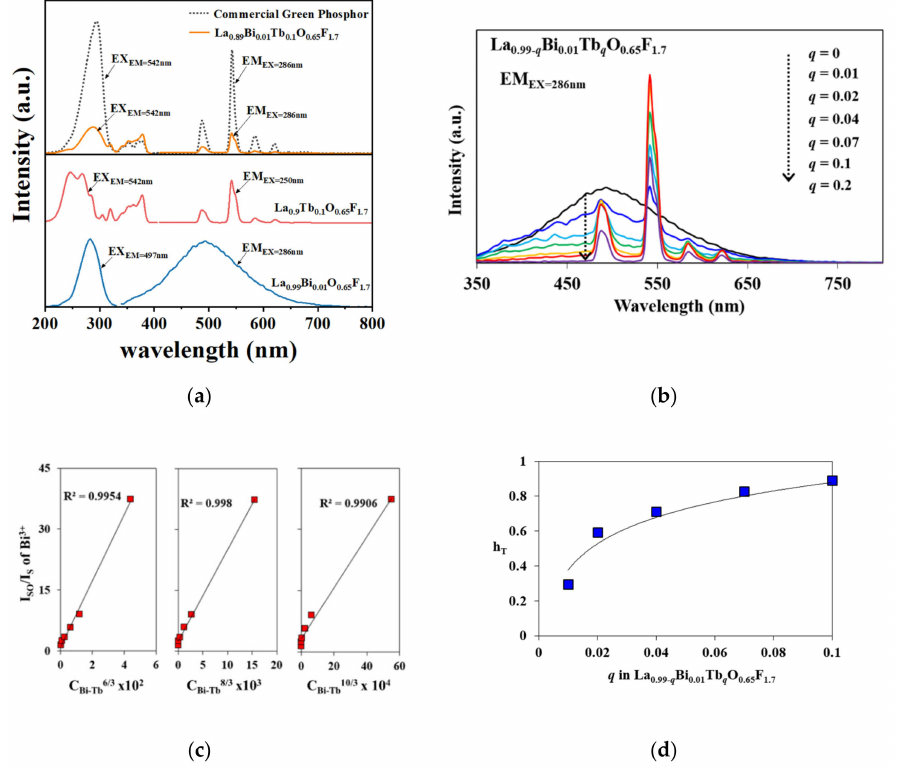
Figure 4. ( a ) PL excitation and emission spectra of La 0.99 Bi 0.01 O 0.65 F 1.7 , La 0.9 Tb 0.1 O 0.65 F 1.7 , La 0.89 Bi 0.01 Tb 0.1 O 0.65 F 1.7 , and commercial green LaPO 4 :Ce 3+ /Tb 3+ phosphors; ( b ) the emission spec- tra of La 0.99 − q Bi 0.01 Eu q O 0.65 F 1.7 ( q = 0–0.2) phosphors under 286 nm excitation; ( c ) the plot of I SO /I S versus C Bi-Tb α /3 ( α = 6, 8, and 10); ( d ) energy-transfer efficiency from Bi 3+ to Tb 3+ in the phosphors. As shown in Figure 5, the chromaticity coordinates, x and y , were in accordance with the desired CIE values from the blue to green wavelength regions for La 0.99 − q Bi 0.01 Tb q O 0.65 F 1.7 ( q = 0–0.2) phosphors (EX = 286 nm). When the concentration of Tb 3+ ions in the La 0.99 − q Bi 0.01 Tb q O 0.65 F 1.7 ( q = 0–0.2) phosphors increased from q = 0 to 0.02 and 0.1, the emission colors exhibited a gradual shift from blue to green emission regions. The CIE values are summarized in the inset of Figure 5, along with the values obtained for the phosphors. The CIE coordinates of the blue and green regions of the phosphor CIE diagram were observed to be x = 0.240 and y = 0.334, x = 0.239 and y = 0.340, x = 0.254 and y = 0.436, and x = 0.267 and y = 0.535 for values of q = 0, 0.01, 0.04, and 0.1, respectively. The emission of the phosphors subject to 312 nm hand-lamp excitation was blue and green. This green-emitting light was adopted for a high color-rendering index to apply to pc UV LEDs. This La 0.89 Bi 0.01 Tb 0.1 O 0.65 F 1.7 phosphor can be prepared as a green-emitting component for fabrication of a 275 nm UV LED chip. The photoluminescence and electroluminescence (EL) spectra resulting from 275 nm UV excitation of the green La 0.89 Bi 0.01 Tb 0.1 O 0.65 F 1.7 phosphor with blue Ba 3.8 Ce 0.1 Na 0.1 Ca 5 Al 2 Si 6 O 24 and red La 0.94 Bi 0.01 Eu 0.05 O 0.65 F 1.7 phosphors were monitored as shown in Figure 6, respectively [8,24]. The pc UV LED was prepared at 3.2 V and 20 mA after the phosphors were packaged on a 275 nm LED chip (inset). A CRI (R a ) of 94.9 at CCTs of 4373 K with CIE coordinates of x = 0.36 and y = 0.37 was determined for the 275 nm chip fabricated with the white-light pc UV